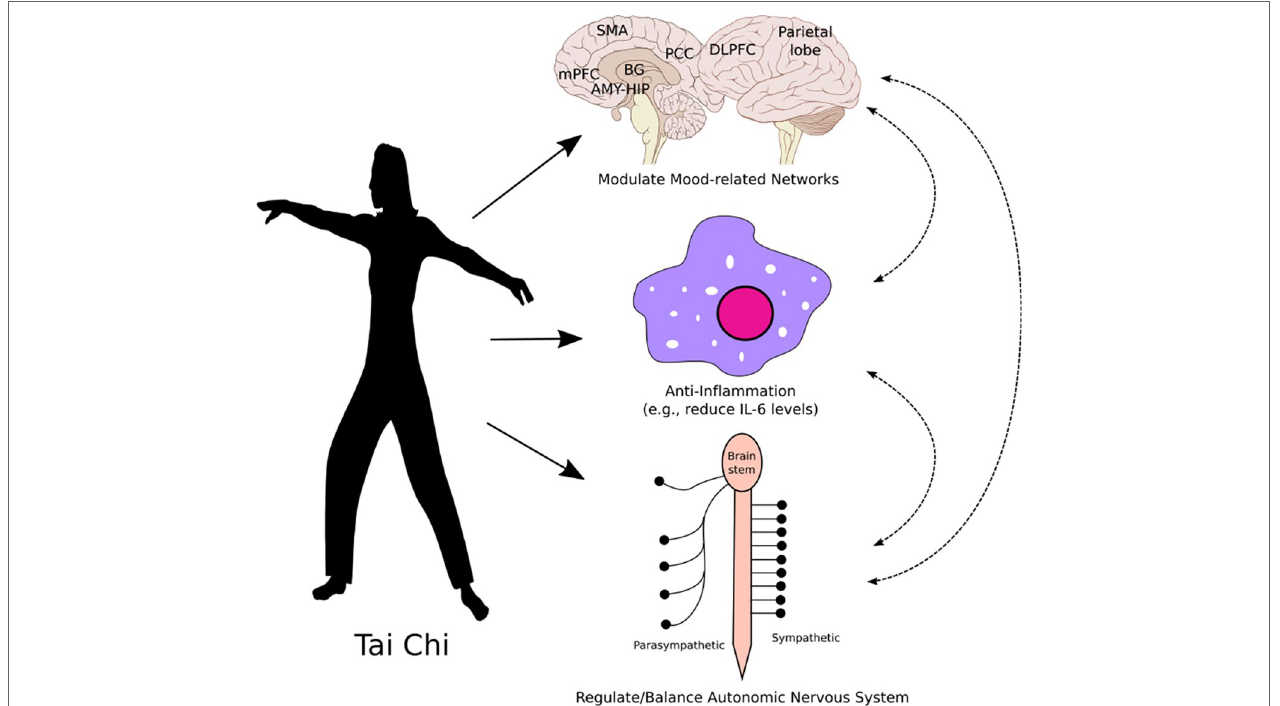
FIGURE 1 | Hypothesized mechanisms of Tai Chi treatment of depression: directly and indirectly modulating the activity and connectivity of key brain regions involved in depression and mood regulation, reducing neuro-inflammatory sensitization, and modulating the autonomic nervous system. Abbreviations: AMY, amygdala; BG, basal ganglia; DLPFC, dorsolateral prefrontal cortex; HIP, hippocampus; mPFC, medial prefrontal cortex; PCC, posterior cingulate cortex; SMA, supplementary motor